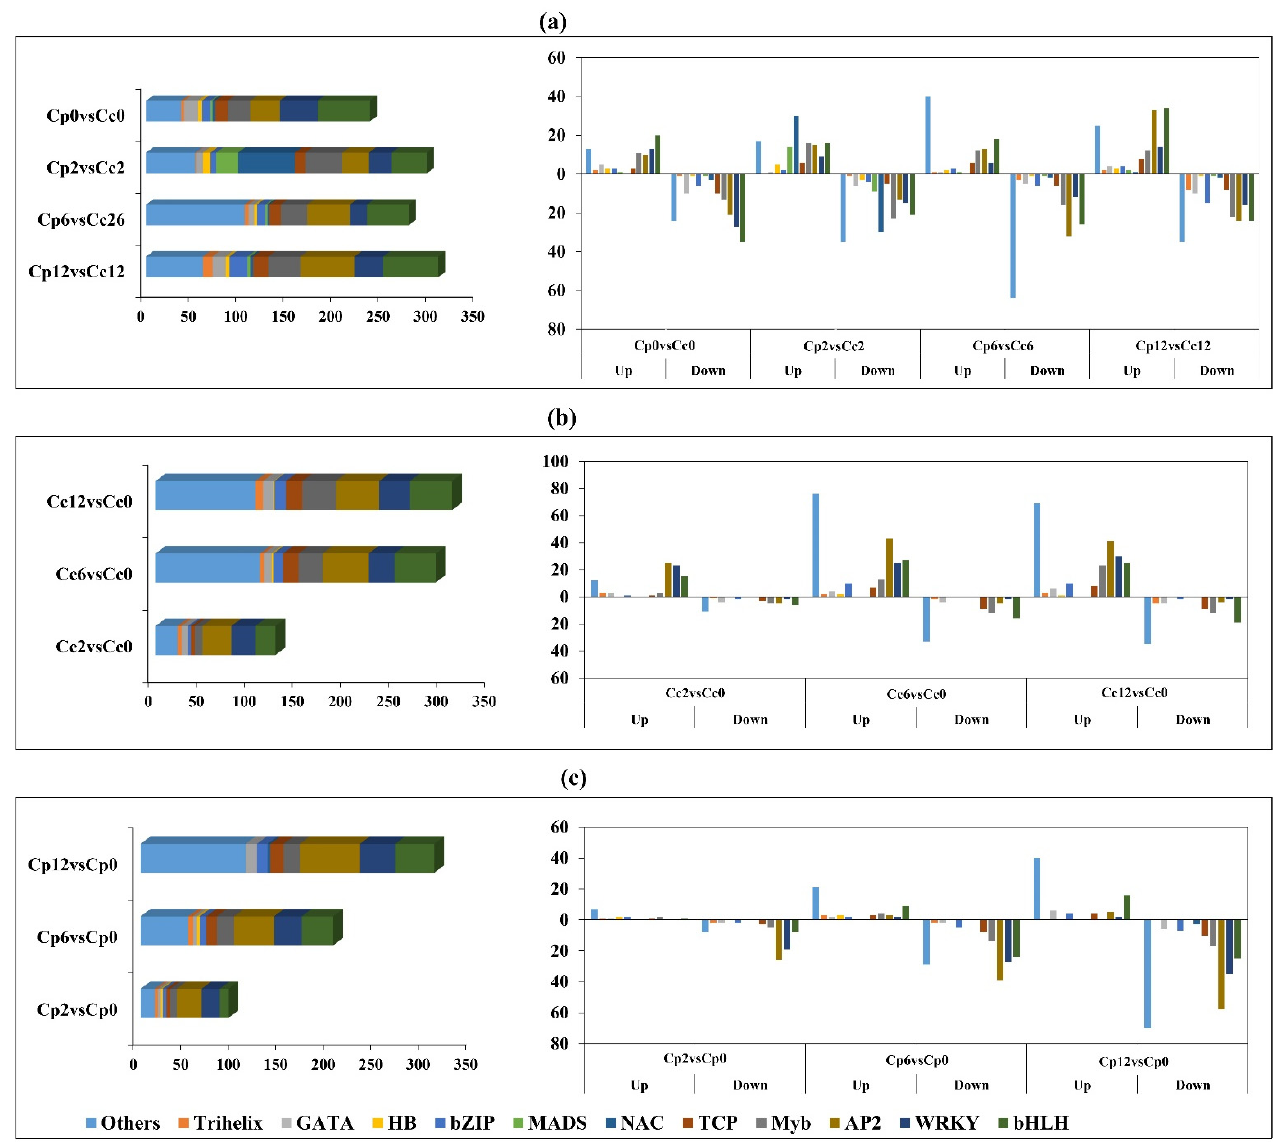
Figure 4. Cold-stress-responsive TF prediction ( a ) Family distribution of the transcription factors and number of upregulated and downregulated transcription factor family members occurring in the C. pubescens vs. C. chinense at different time points of cold stress. ( b ) Family distribution of the transcription factors and number of upregulated and downregulated transcription factor family members occurring in C. pubescens at different time points of cold stress ( c ) Family distribution of the transcription factors and number of upregulated and downregulated transcription factor family members occurring in C. chinense at different time points of cold stress.